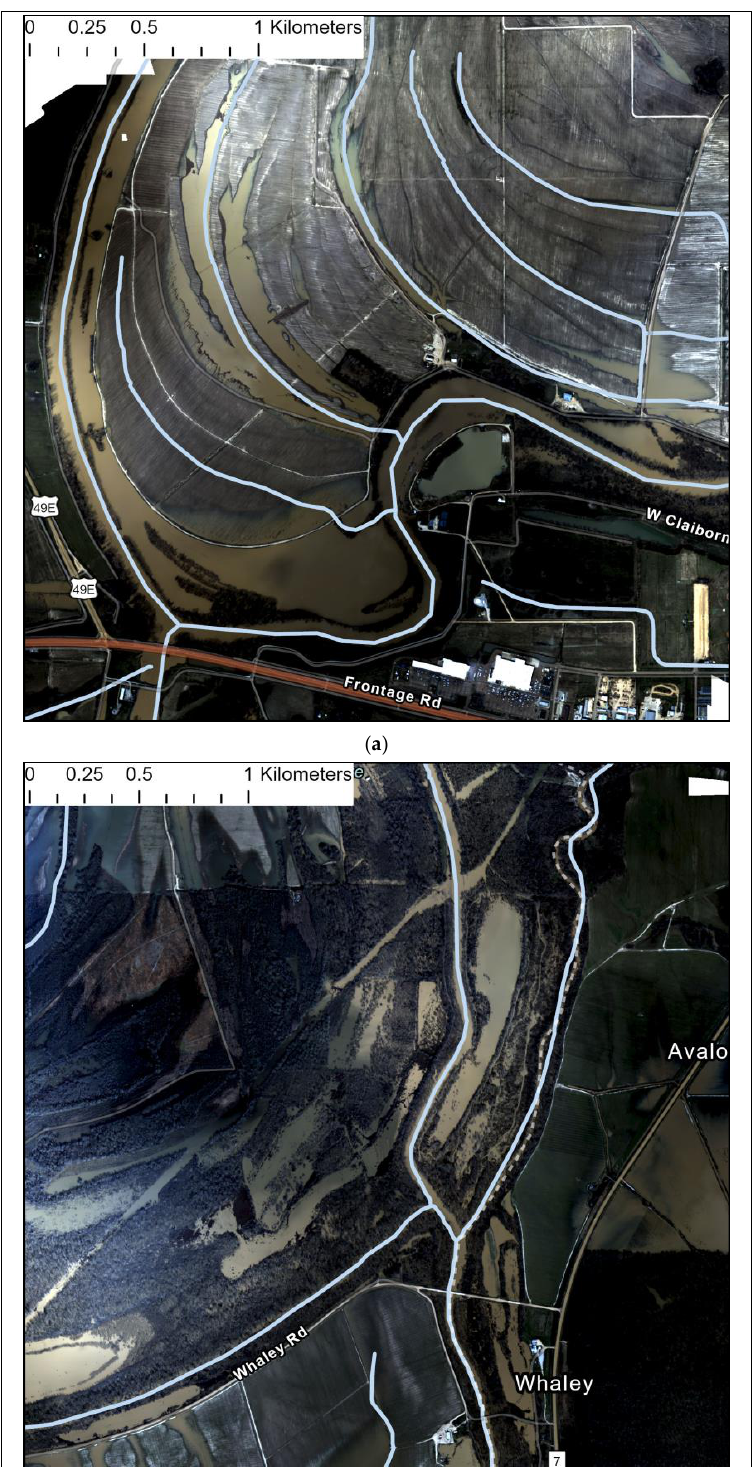
Figure 5. UAS-collected RGB imagery showing flood conditions from Feb. 25, 2019 flight ( a ) over an agricultural area northwest of Greenwood, MS along the Tallahatchie River and ( b ) along the Yalobusha River near Whaley, MS (north of Greenwood, MS). Blue lines denote water flowlines defined by the National Hydrography Dataset.